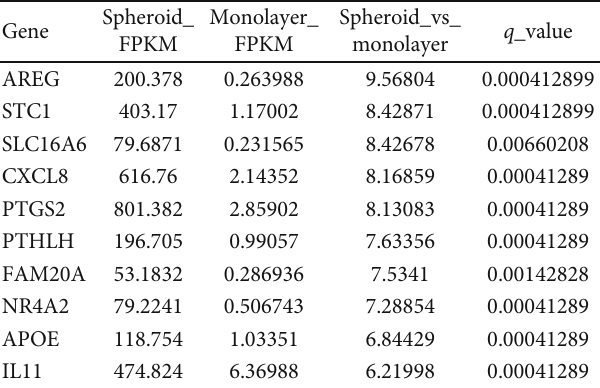
Table 2: Among the DEGs between the spheroid and monolayer culture groups, we extracted genes with Log q value < 0.05, and FPKM > 50 in the spheroid culture